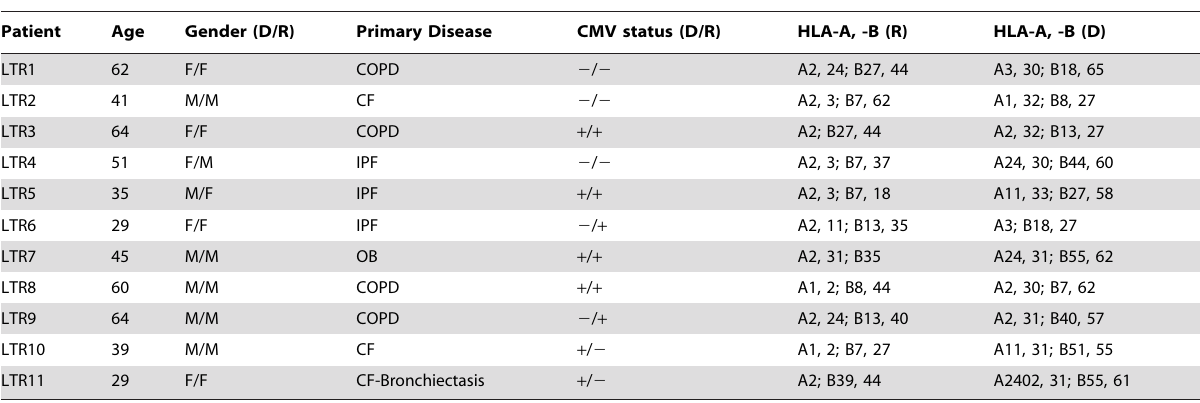
Abbreviations: donor (D), recipient (R), female (F), male (M), cystic fibrosis (CF), chronic obstructive pulmonary disease (COPD), idiopathic pulmonary fibrosis (IPF), idiopathic bronchiolitis obliterans (OB).